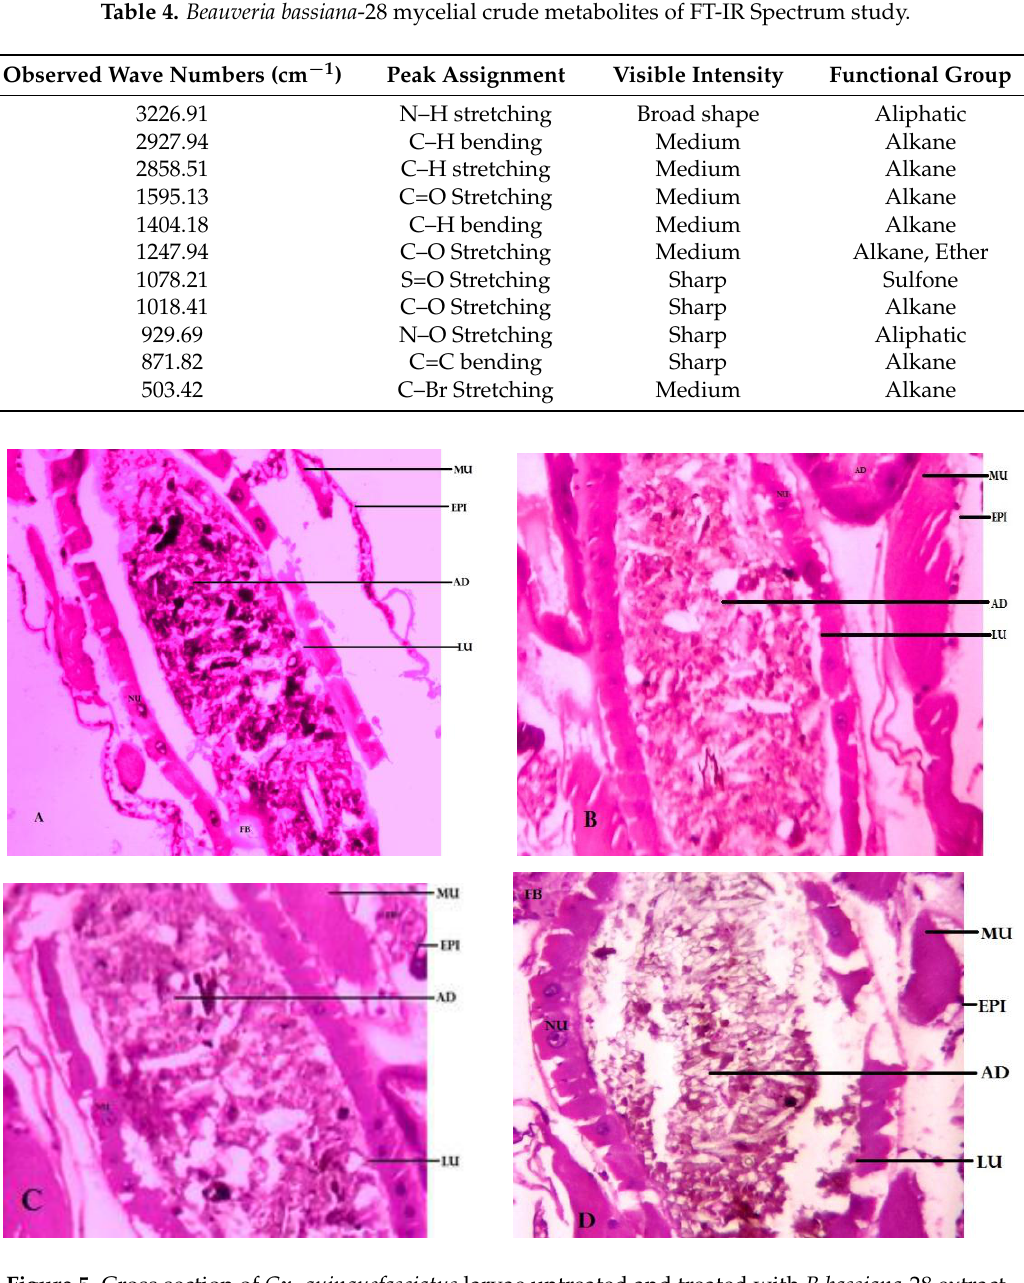
Figure 5. Cross section of Cx. quinquefasciatus larvae untreated and treated with B.bassiana -28 extract Control ( A ) (untreated) compared with ( B ) 6 h Treated ( C ) 12 h treated and ( D ) 24 h treated, Vacuolated gut epithelium (epi), gut lumen (lu), adipose tissue(ad), muscles (mu), nucleus (nu) and fat body